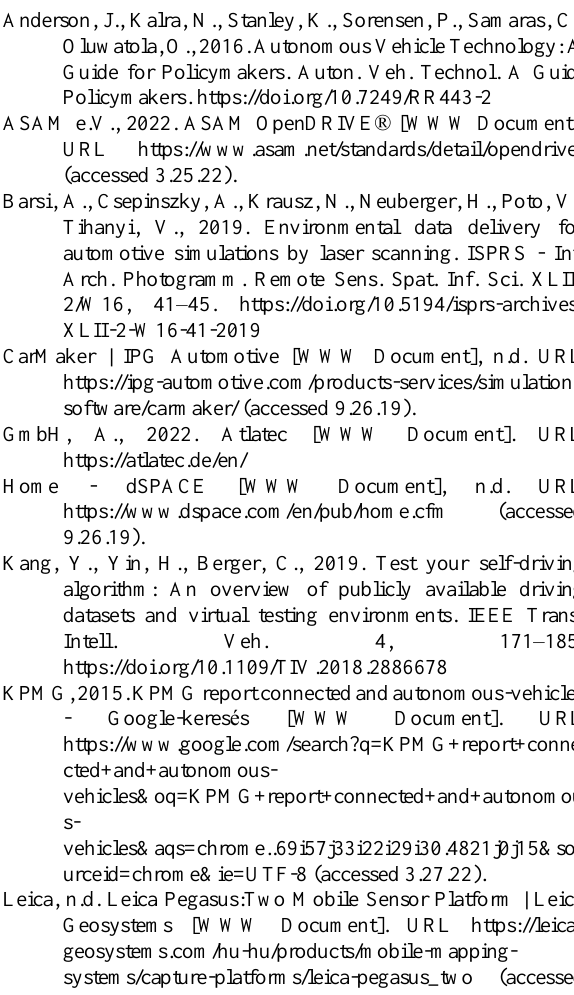
Figure 8. Real-world model on Südtangente near Karlsruhe,